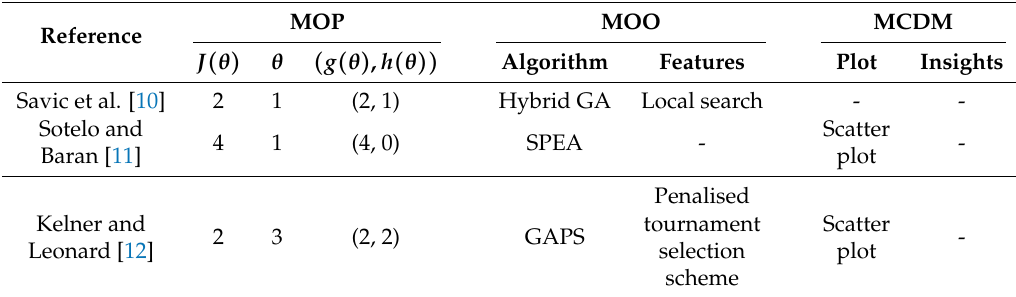
Table 1. Summary of MOOD procedures for WDS design concept. J ( θ ) refers to the number of objectives; θ to the number of sets of decision variables and g ( θ ) , h ( θ ) to the number of sets of inequality and equality constraints